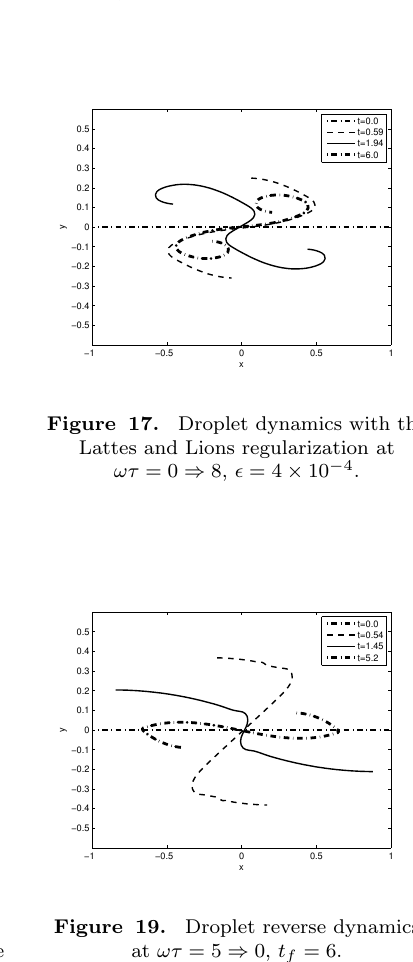
Figure 15. The dependence of β ( l,t i ) with 2 jump on l for ωτ = 0 ⇒ 8, (cid:15) = 0.